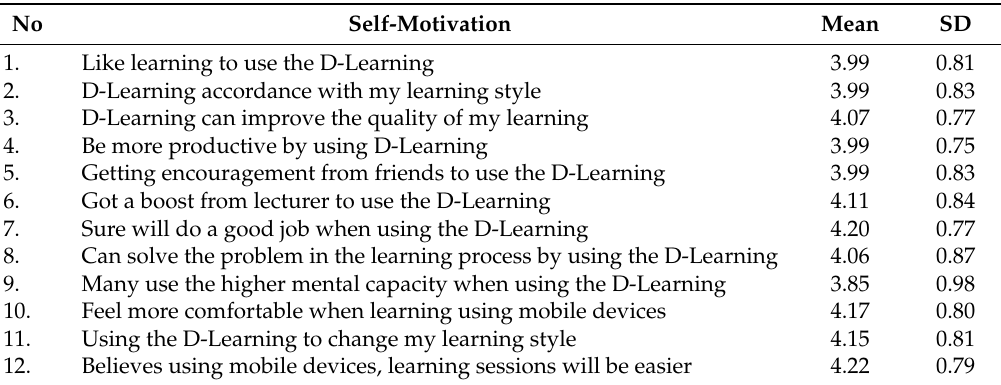
Table 2. Perception of